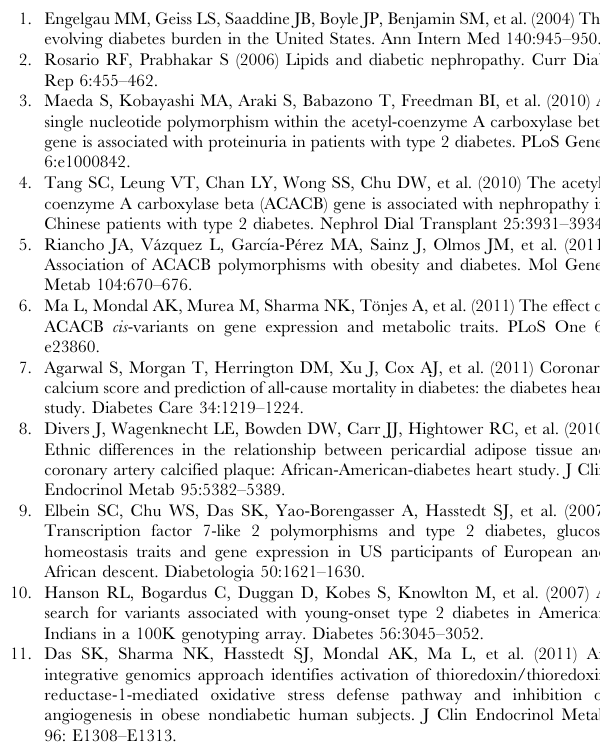
Figure S2 BMI distribution by age for different birth era groups in non-diabetic full-heritage Pima Indians. Figure S3 ACACB expression in transformed lymphoblast cell lines in HapMap/Sanger gene expression data set (in CEU, JPT, &YRI).